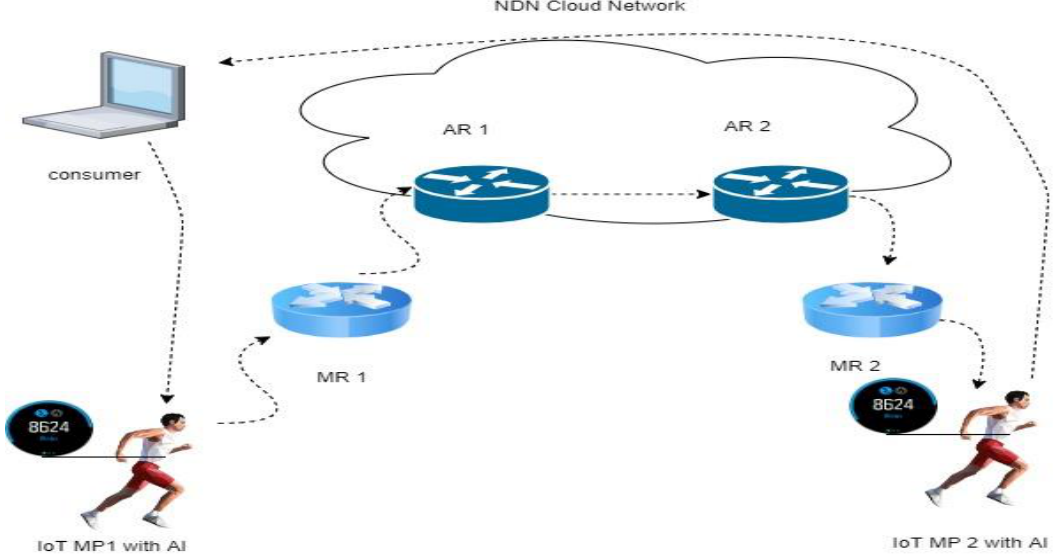
Figure 7. Hybrid NeMO with cloud operation.